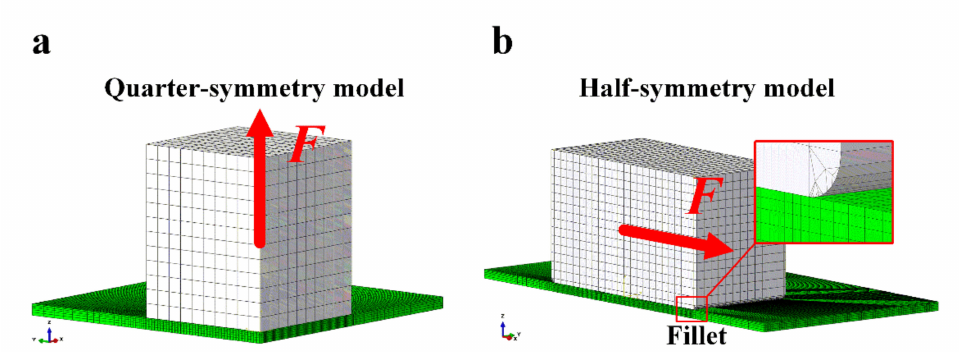
Figure 3. Mesh of 3D finite element (FE) model of ice cuboid adhered to an elastic coating ( t / a = 0.01). ( a ) Quarter-symmetry model for normal separation. ( b ) Half-symmetry model for shear separation. The inset shows the fillet of the ice cuboid.